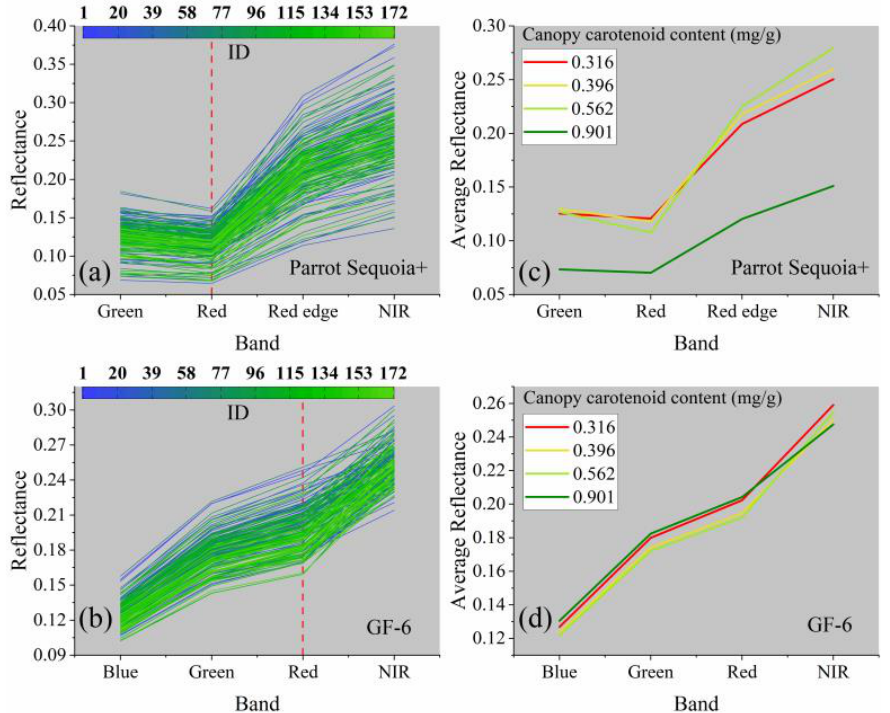
Figure 15. Band reflectance comparison chart of Parrot Sequoia+ and GF-6 images in 2019-G valida- tion quadrat. ( a ) Band reflectance map of 172 PeITCs in Parrot Sequoia+ image. ( b ) Band reflectance map of 172 PeITCs in GF-6 image. ( c ) Mean band reflectance map corresponding to different Car estimations in Parrot Sequoia+ image. ( d ) Mean band reflectance map corresponding to different Car estimations in GF-6 image.